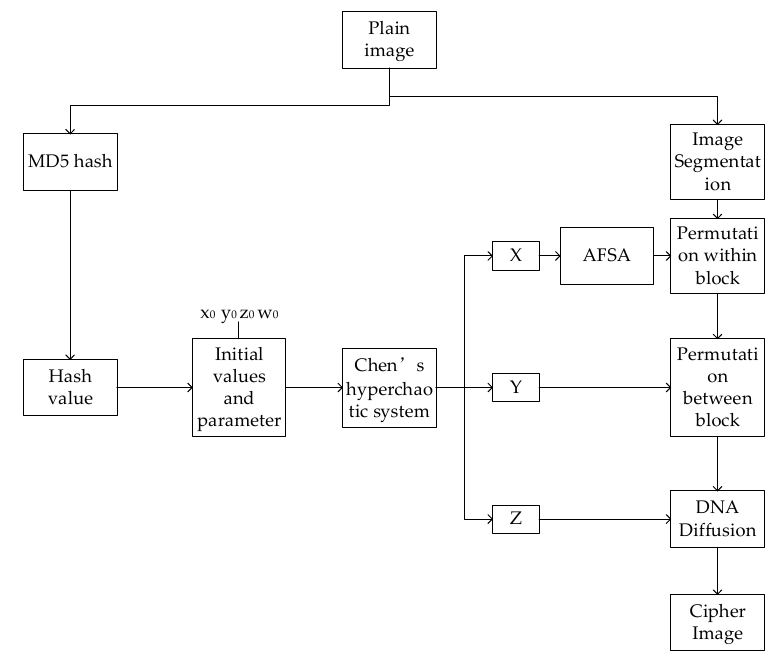
Figure 3. The flow chart of the scheme.